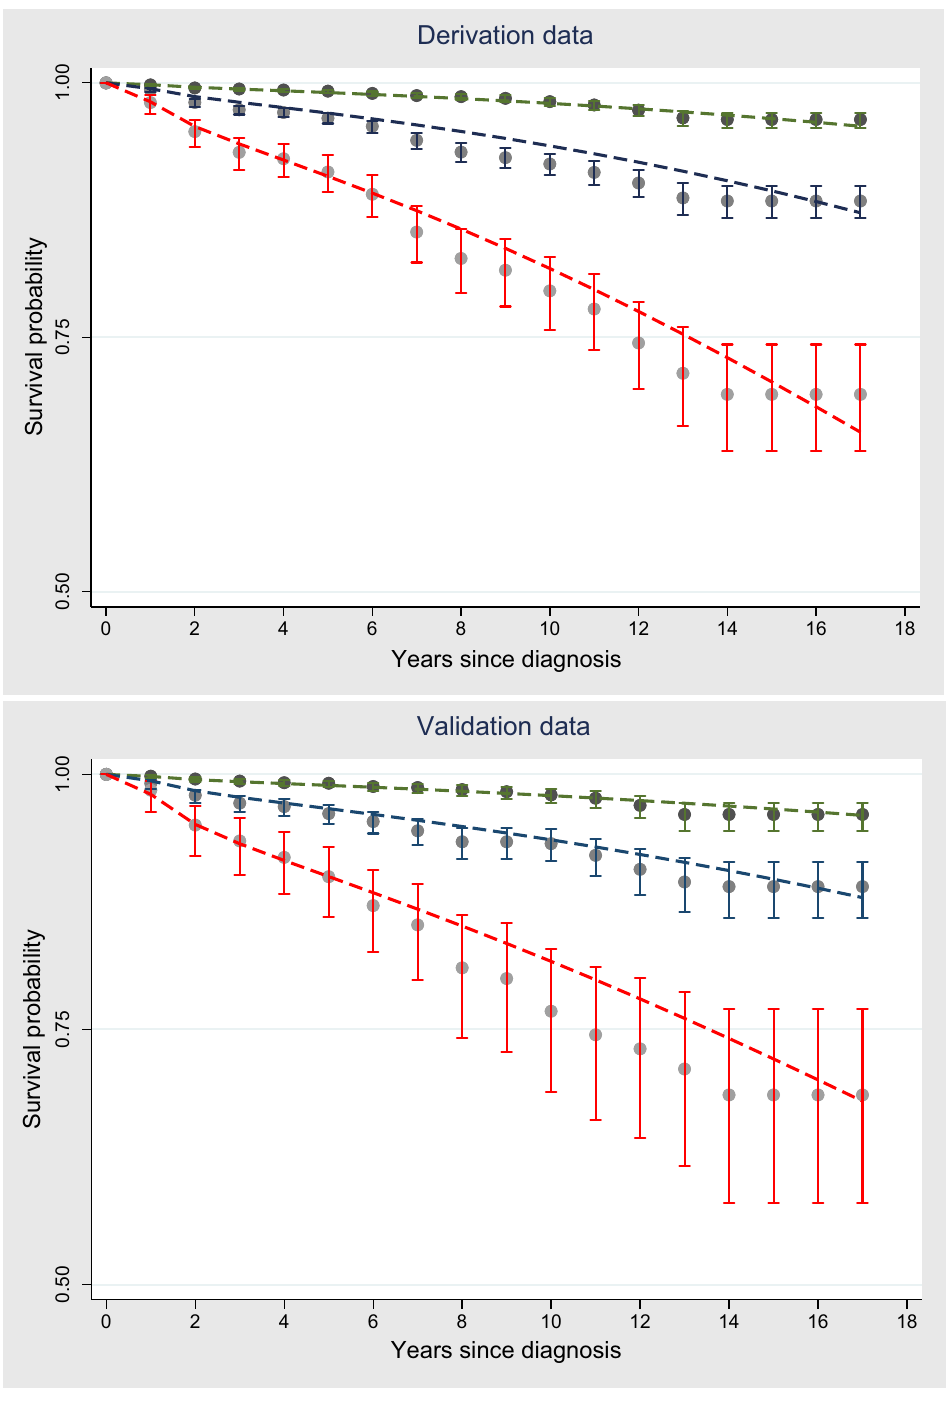
Figure 4. Smooth dashed lines represent predicted survival probabilities, and vertical capped lines represent Kaplan–Meier estimates with 95% confidence intervals. Three prognosis groups are plotted: the “Good” group (green lines), the “Intermediate” group (navy blue lines), and the “Poor” group (red